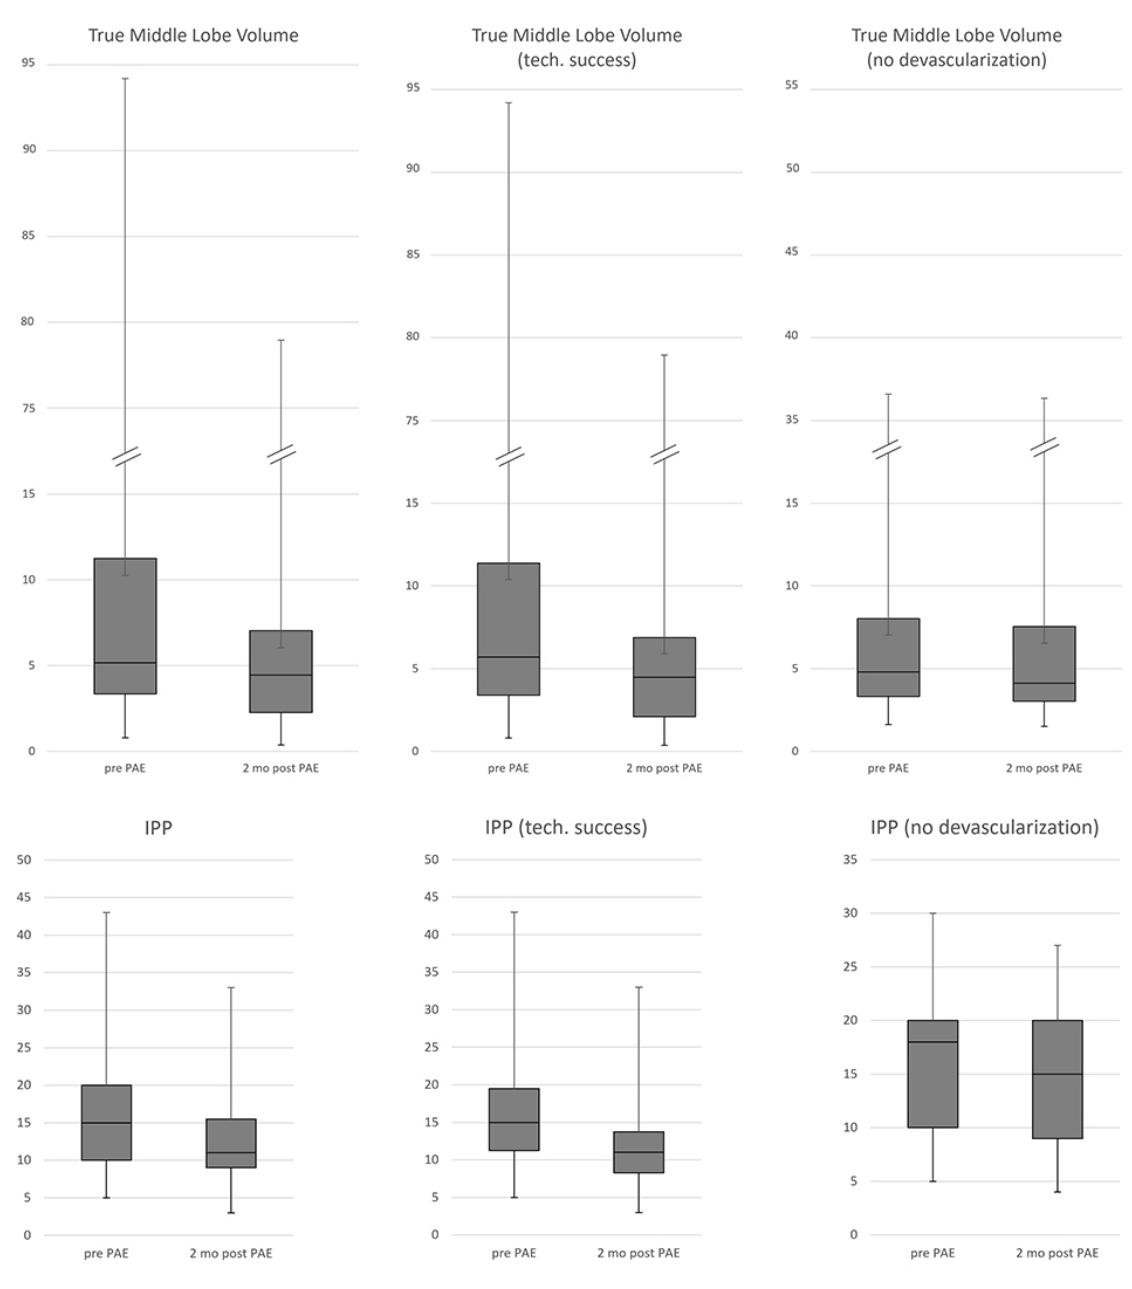
Fig. 4. Volume of the true middle lobe (TML) and height of the intravesical prostate protrusion (IPP) in the course after PAE. Both the volume reduction of the TML and the height of the IPP are reduced more significantly after successful devascularisation of the TML than after incomplete